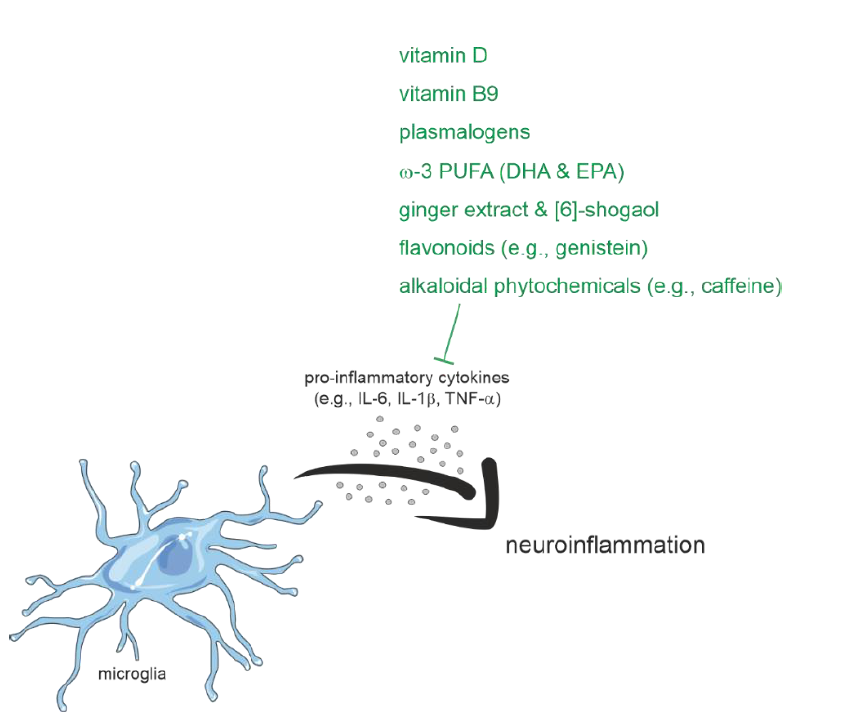
Figure 4. Influence of nutritional components on inflammation. PUFA: polyunsaturated fatty acid. DHA: docosahexaenoic acid. EPA: eicosapentaenoic acid.